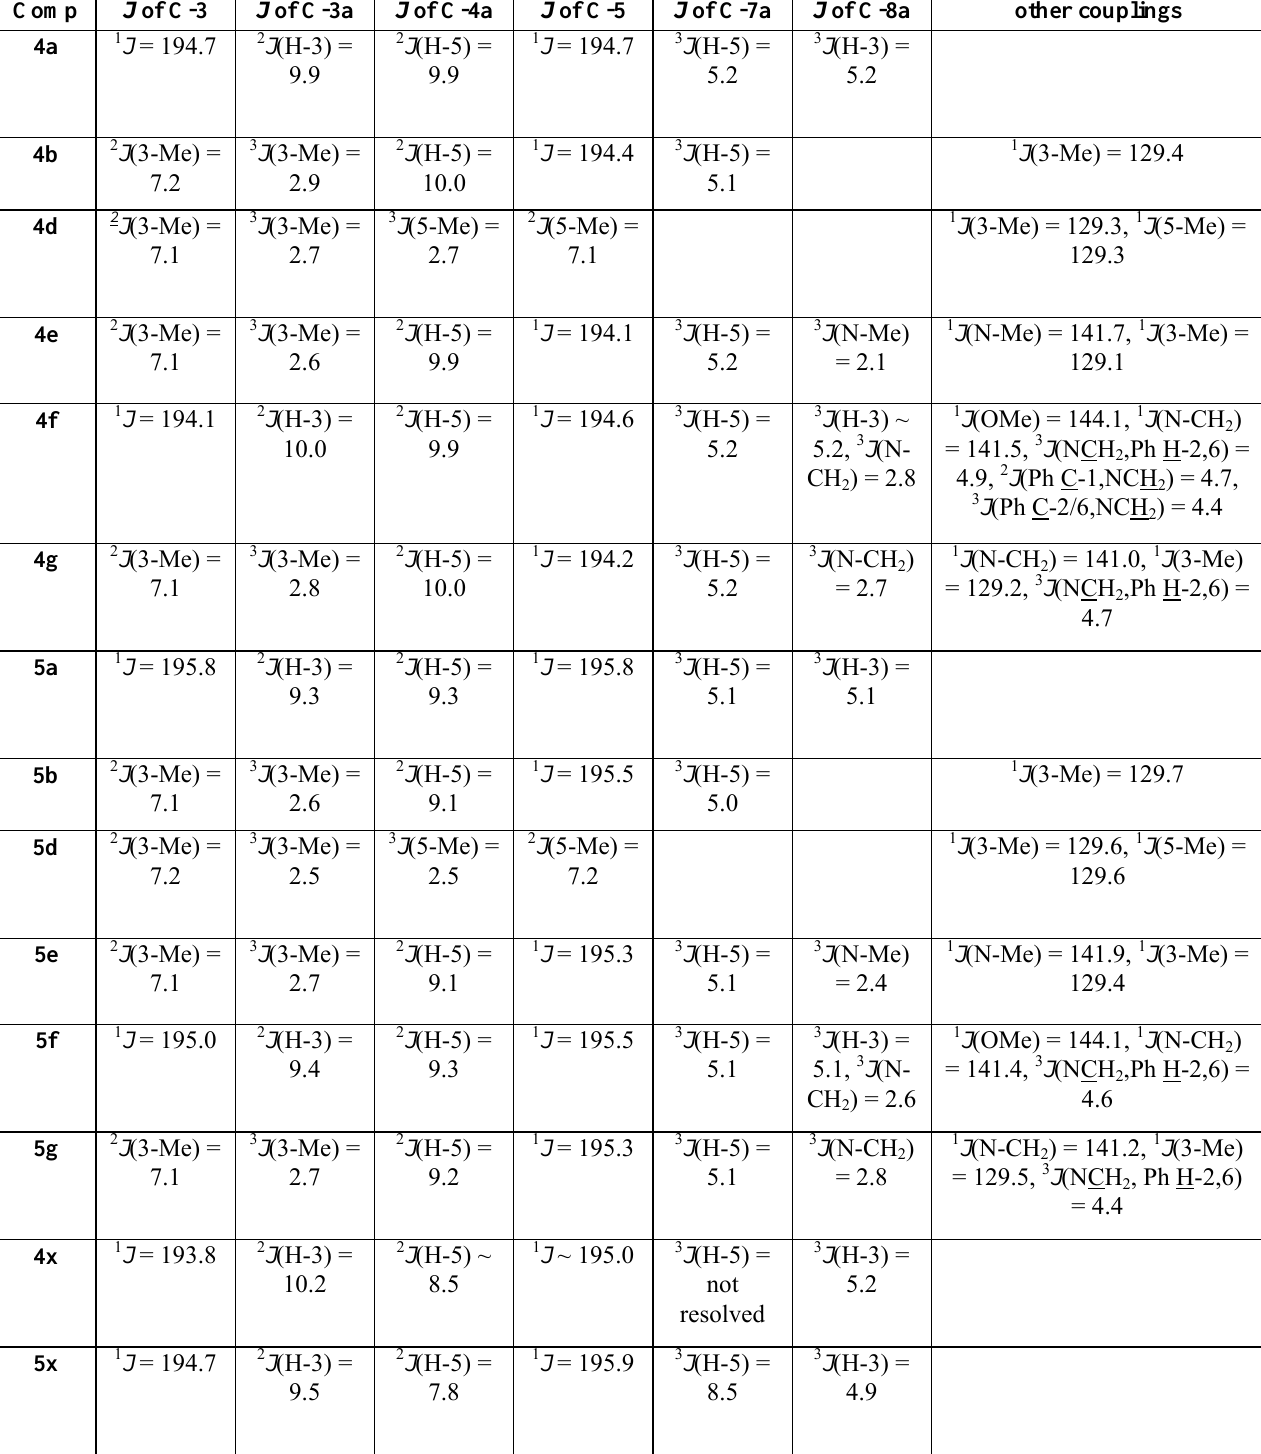
Table 4. Selected 13 C, 1 H spin coupling constants of 4a - b , 4d - g , 5a - b , 5d - g , 4x and 5x (Hz, solvents as listed in Table